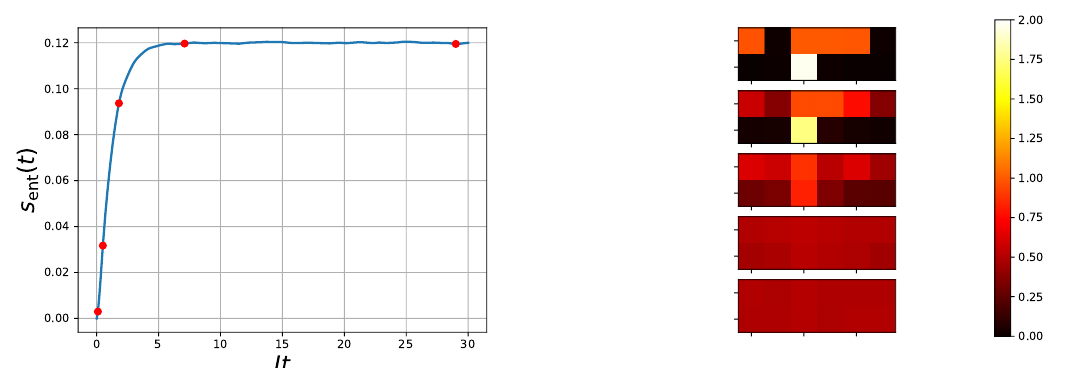
(a) Entanglement entropy density between the two (b) Local density of bosons as a function of time. legs of the ladder as a function of time. Later times appearing farther down the page. Figure 4: Quantities measured in the BHM: (a) the leg-to-leg entanglement entropy density and (b) the local density on each site as a function of time. The red dots in (a) show the time points at which the snapshots of the local density (b) are taken. The parameters are U / J = 20, and L =